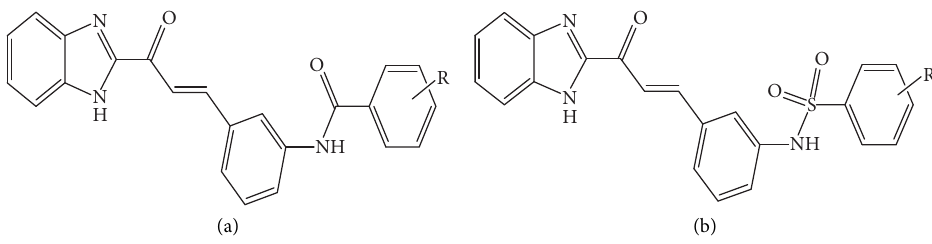
Figure 3: Chemical structure of studied compounds.